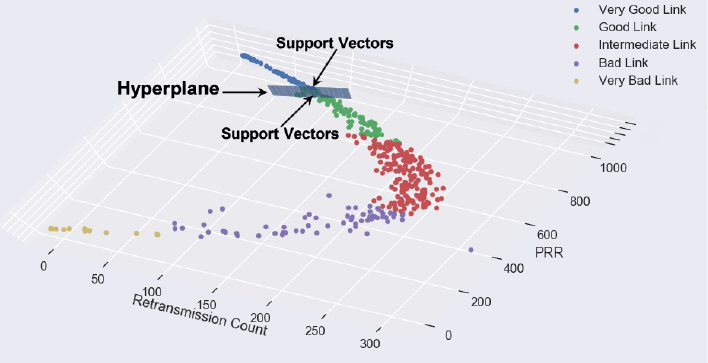
Figure 2. KLSVM—A correlation-based high-dimensional multi-category data classification model with a 3D hyperplane. The support vectors around the hyperplane are consequential training examples under SVM